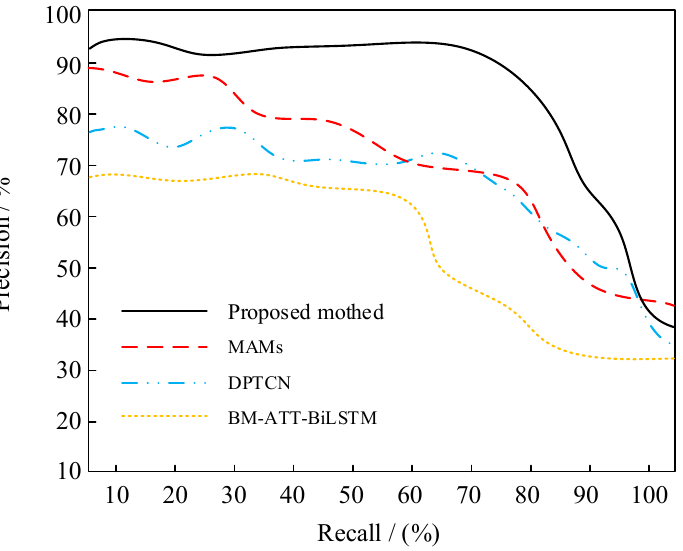
Figure 14. P–R curve of different methods under SCP Figure 14. P – R curve of different methods under SCP dataset.